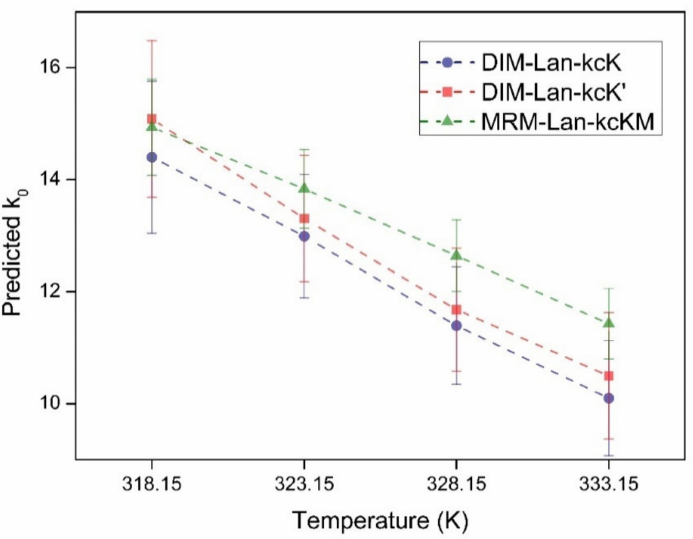
Figure 8. Estimated k 0 values of ketoprofen on SIL-Aerogel at different temperatures. Method DIM-Lan-kcK, DIM-Lan-kcK’, and MRM-Lan-kcKM were applied following the procedure explained in Sections 4.1 and